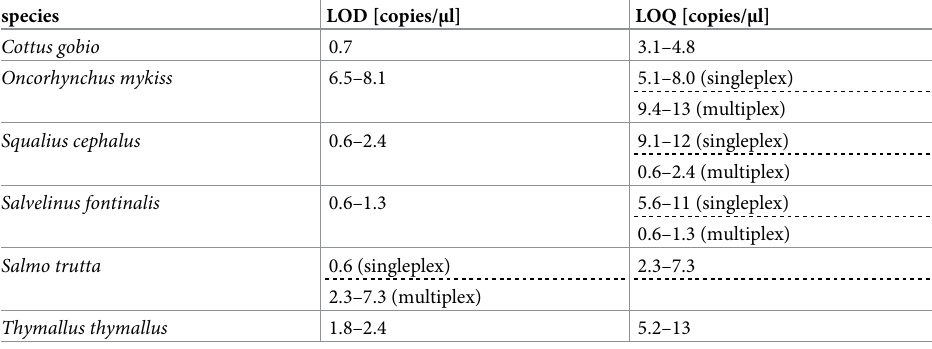
Table 4. Species-specific LOD and LOQ in singleplex and multiplex celPCR.